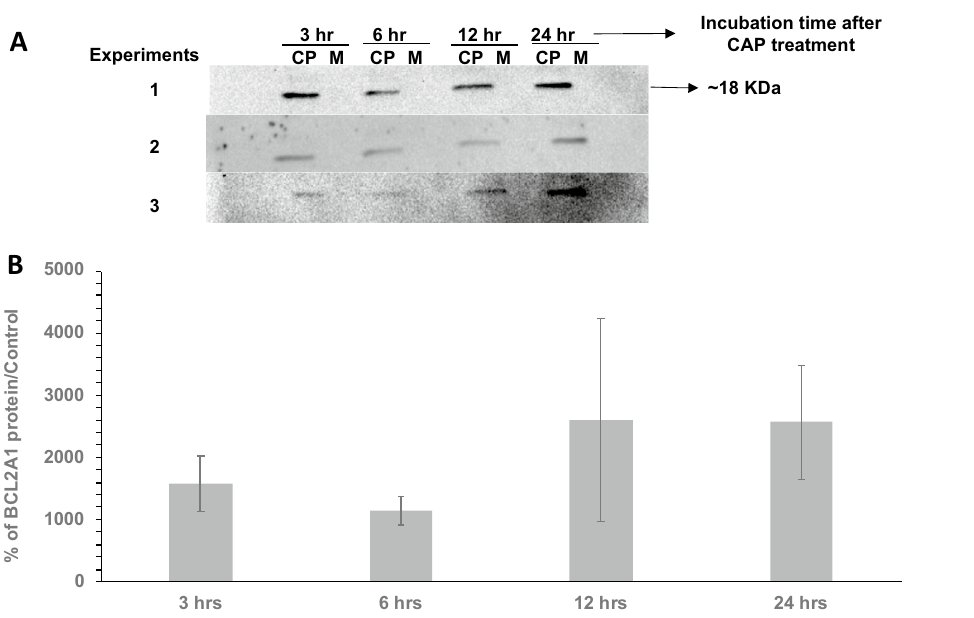
were created. The Incucyte Cell Cycle Green/Red tag is a fluorescent, single cassette indicator expressing both the GFP (green fluorescent protein) and mKate2 (red fluorescent protein) to distinguish between cells in the G1 and S/G2/M cell cycle phase without altering cell function. The Incucyte live cell imaging experimental setup is detailed in the method section. MDA-MD-231 stable cells were monitored for cell confluence and G1 (Red) or S/G2/M (Green) or S to G1 transition (S-G1, Yellow) phases of the cell cycle for up to 3 days by Incucyte live imaging. The cells treated with esiRNA-BCL2A1 did not show any changes in cell confluence or cell cycle phases compared to mock cells or esiRNA-control treated cells, but when treated with CHCP at 80p 5 min the viability